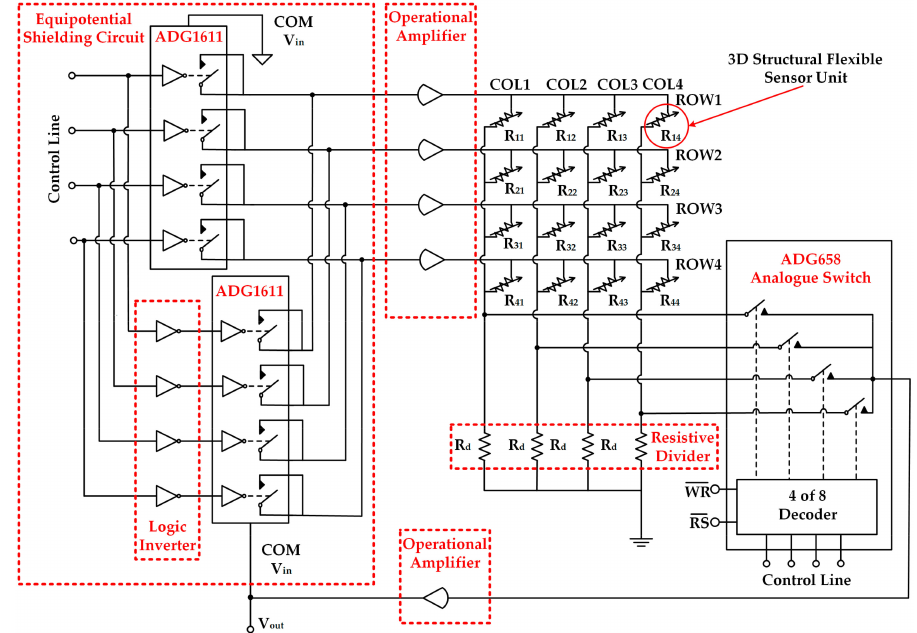
Figure 6. The schematic of the readout circuit schematic for the 4 × 4 3D structural flexible tactile sensor array. The controlled ADG1611 in the equipotential shielding circuit is adopted to select the row of the target resistance unit. The ADG658 selects the column of the target resistance. The resistance value of each resistive divider (R d ) is set up to 10 k Ω , which is slightly greater than or equal to the resistance value of the target sensing unit. The amplification ratio of each amplifier is set up to